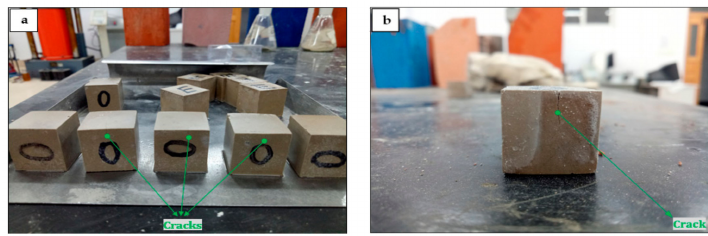
ratios: ( a ) Water:cement ratio of 0.35; ( b ) water:cement ratio of 0.50.